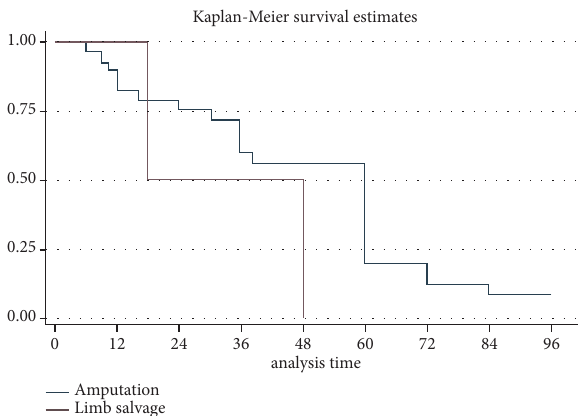
Figure 2: Kaplan–Meier survival curve for all patients with COM- derived SCC was included in our analysis. Table 3: Factors potentially associated with increased risk of re- currence, metastasis, and/or all-cause death. COM: chronic osteo- myelitis, SCC: squamous cell